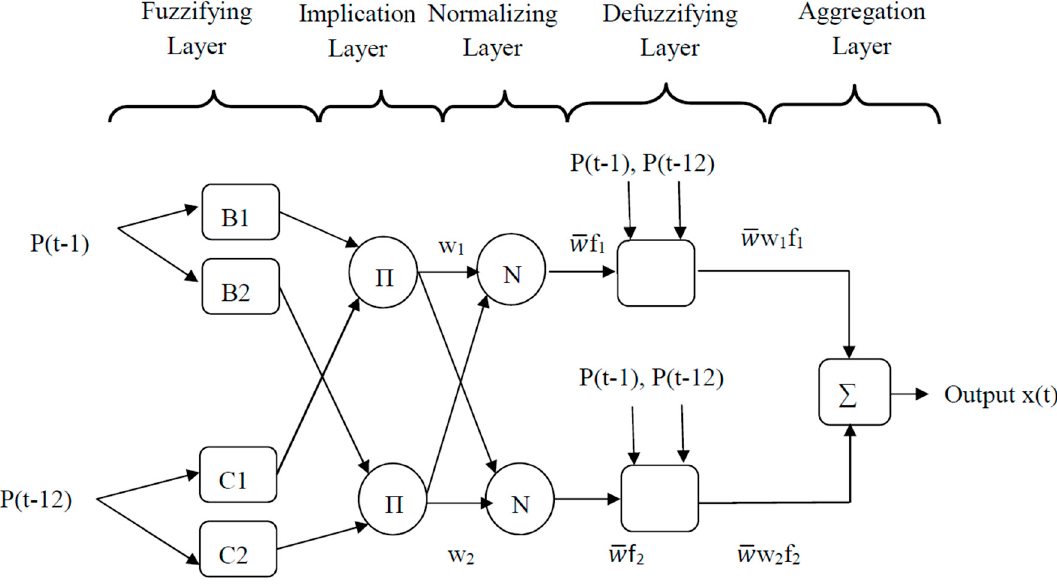
Figure 6. Adaptive neural fuzzy inference system (ANFIS) structure.